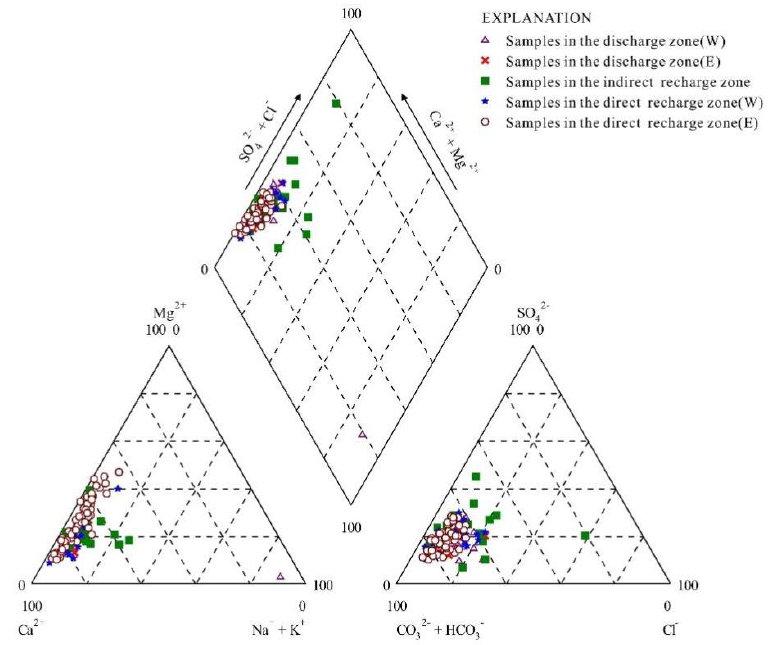
Figure 5. Piper trilinear diagram for the classification of karst water in each zone.